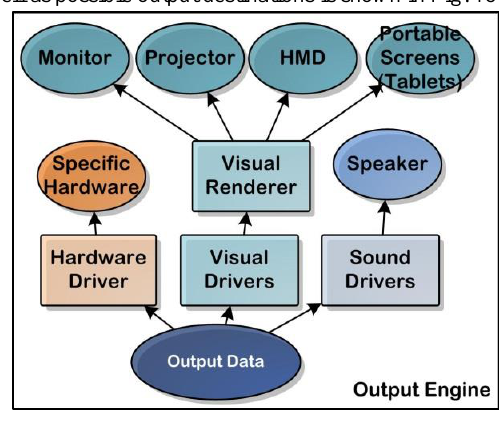
Fig. 15. The Output Engine and its drivers.